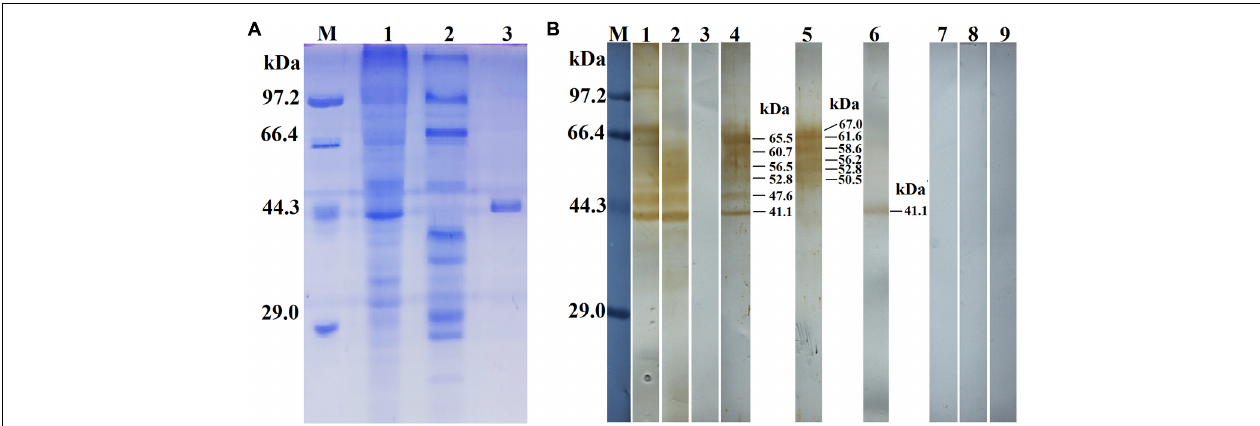
FIGURE 3 | Identification of rTsGS antigenicity. (A) SDS-PAGE analysis of rTsGS. Lane M, protein marker; lane 1, intestinal infectious larvae (IIL) crude proteins; lane 2, IIL ES proteins; lane 3, rTsGS. (B) Western blotting of rTsGS antigenicity. IIL crude proteins (lane 1) and IIL ES proteins (lane 2) were recognized by infection serum, but rTsGS (lane 3) was not recognized by infection serum. Native TsGS in IIL crude proteins (lane 4) and IIL ES proteins (lane 5) and rTsGS (lane 6) were identified by anti-rTsGS serum. IIL crude proteins (lane 7), IIL ES proteins (lane 8), and rTsGS (lane 9) were not recognized by normal mouse serum.